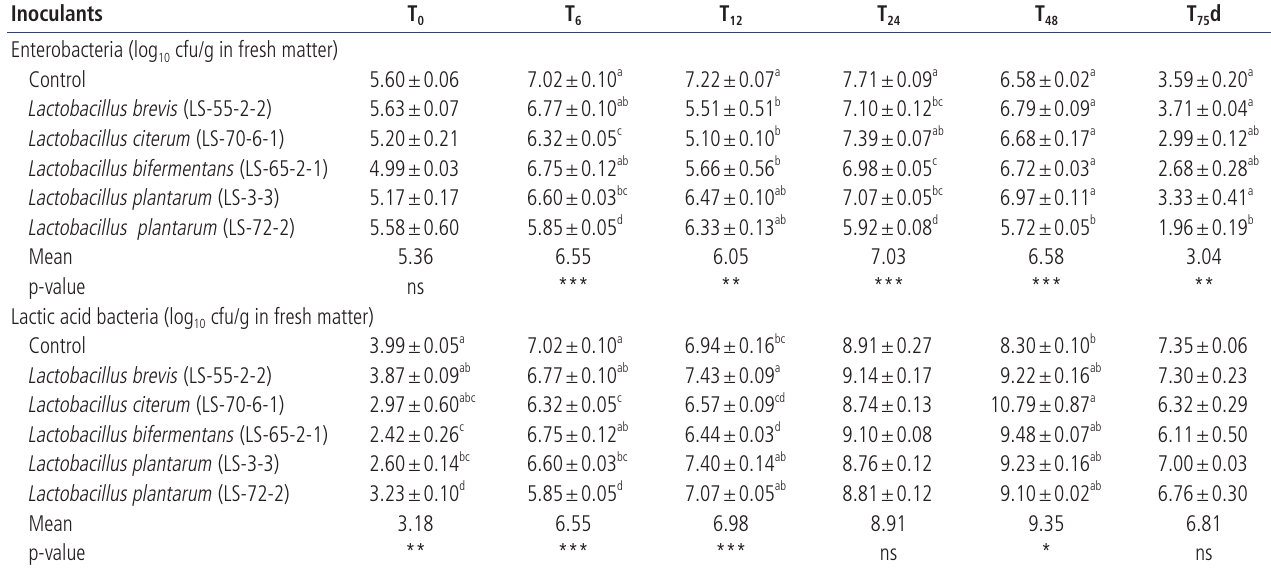
Table 3. Effects of different bacterial inoculants on numbers of enterobacteria and lactic acid bacteria of ensiled silages at different silage opening times